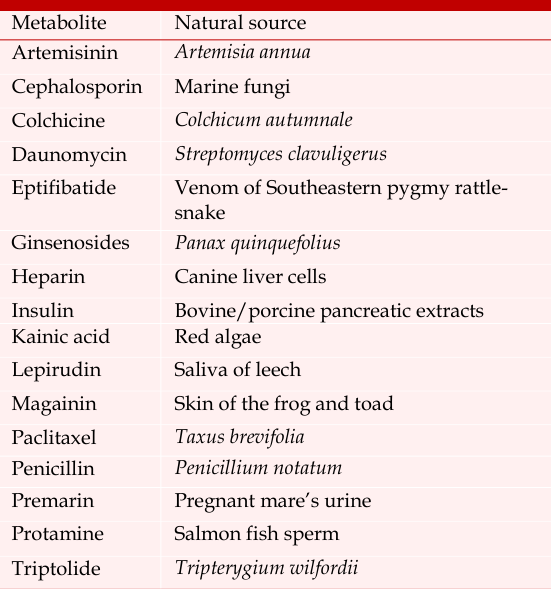
Secondary metabolites from the natural